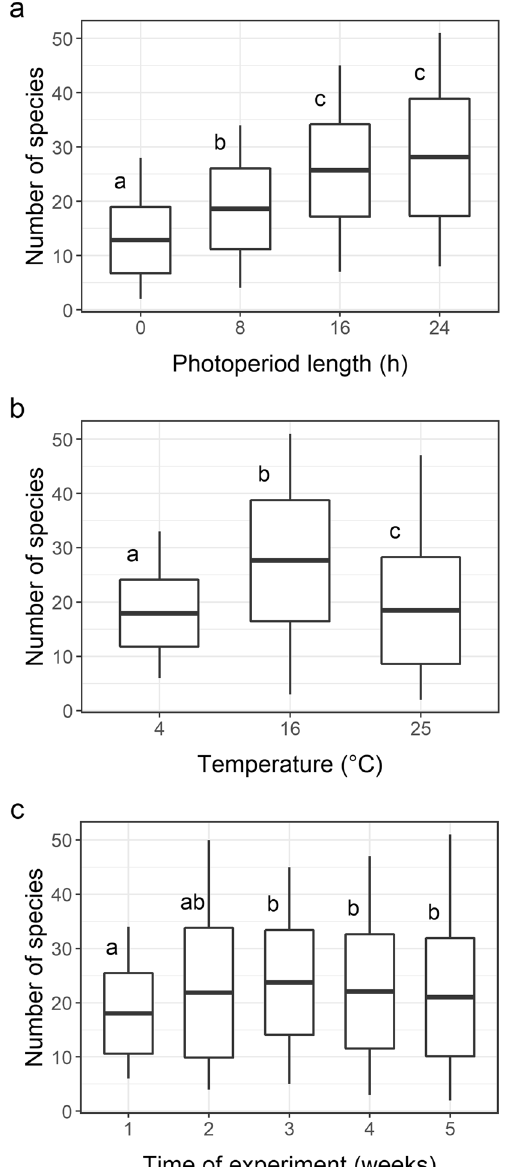
Figure 2. Phytoplankton species richness: ( a ) at different photoperiod lengths, ( b ) at different temperatures, and ( c ) in successive sampling weeks (1–5). The same letters at the boxes denote lack of significant difference ( P ≥ 0.05) between particular groups according to a post-hoc test (whiskers: minimum and maximum values, box: standard deviation, and line: mean; N = 180). The graph was created in R 4.0.4 under RStudio 1.4.1106 using the ‘ggplot2’ package and the data in